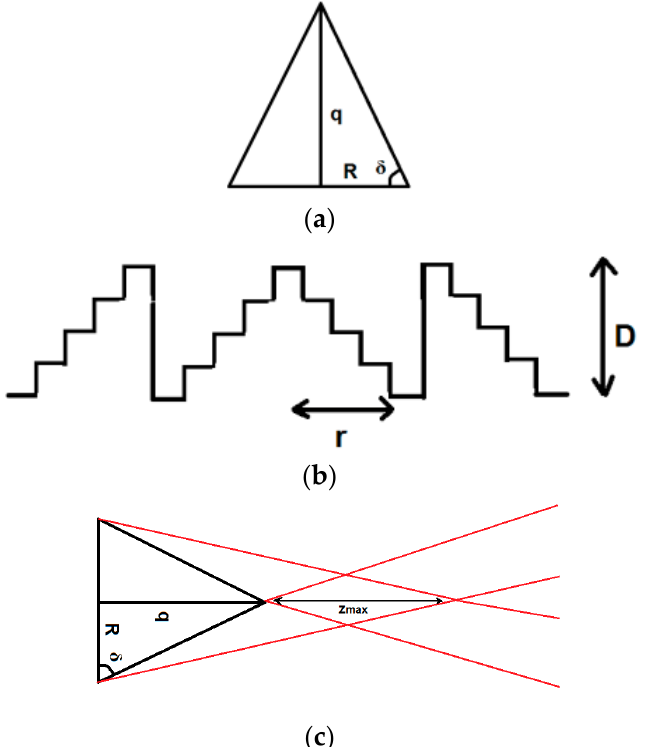
Figure 4. ( a ) Refractive axicon with continuous profile; ( b ) DOE—diffractive (Fresnel) axicon; ( c ) z max —propagation distance for which the Bessel–Gauss beam is diffraction-free.